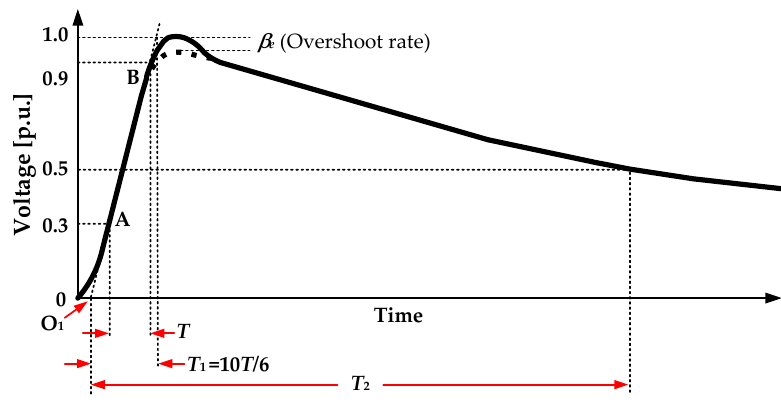
Figure 1. Generated lightning impulse voltage waveform.